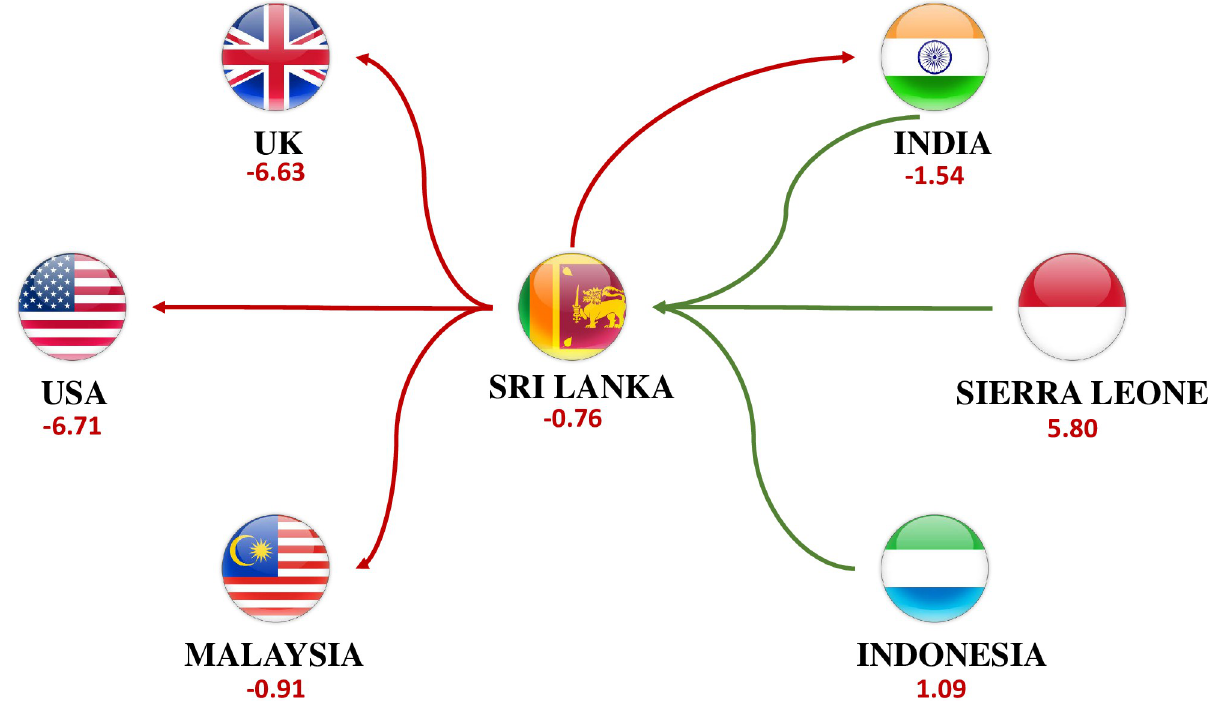
Fig 2. Ego network of Sri Lanka in the lurking oriented land trade network. Incoming links (in green) represent deals that involve companies located in Sri Lanka as investors, outgoing links (in red) represent deals where Sri Lanka is the target country. Below the name of each country, we report its LSLA-score (recall that low values of LSLA-score correspond to countries having an investor profile, while high values correspond to countries showing a target profile).